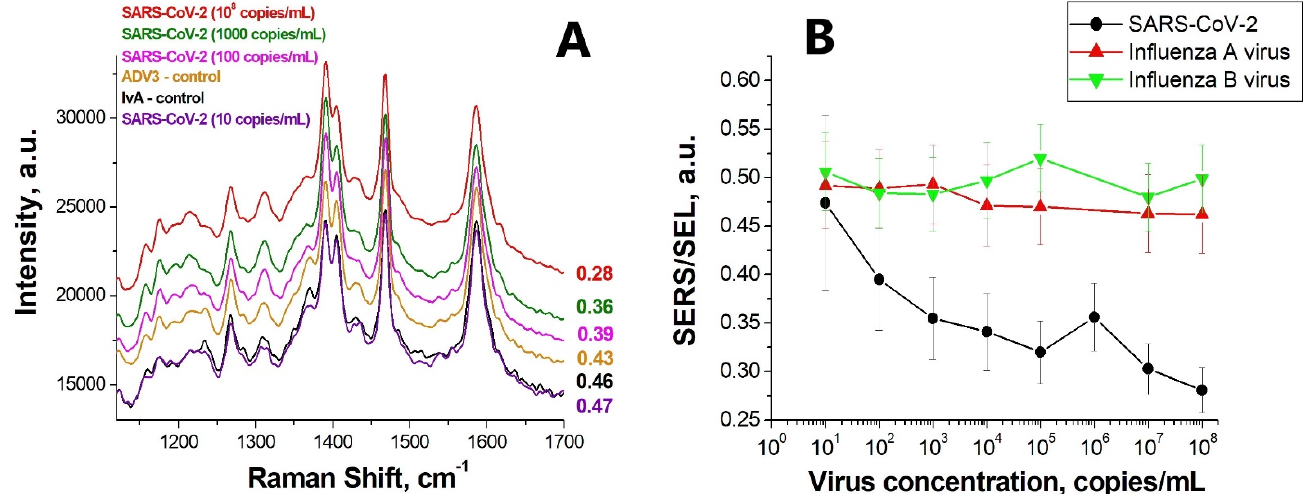
Figure 5. ( A ) Surface-enhanced Raman scattering and luminescence spectra for control viruses and SARS-CoV-2 at different concentrations. ( B ) Dependence of the SERS/SEL parameter on the concentrations of SARS-CoV-2, the influenza A virus, and the influenza B virus.